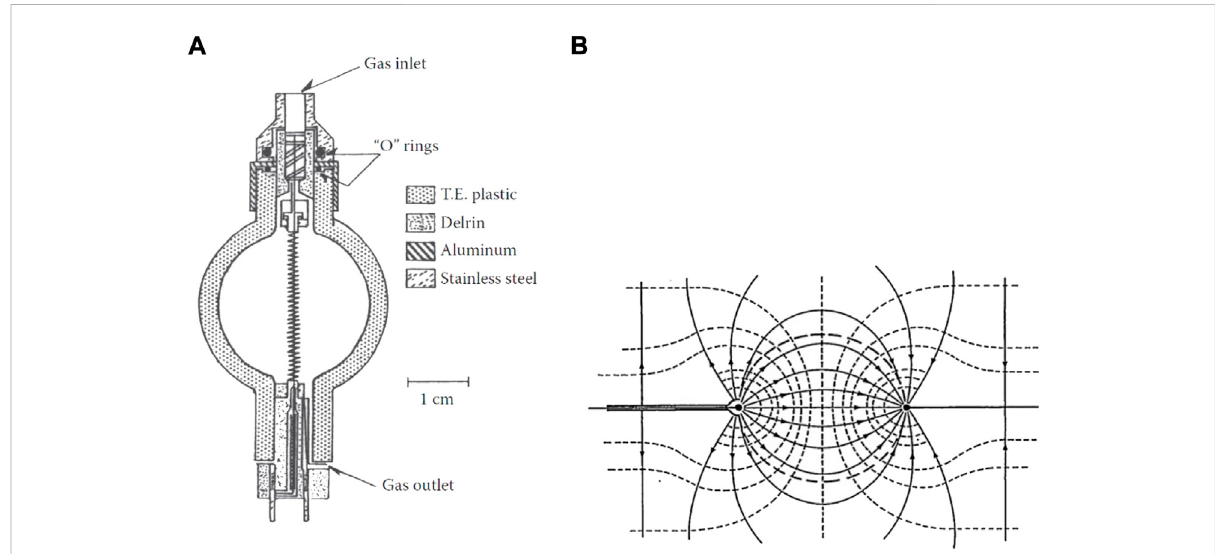
FIGURE 1 Solid-walled and wall-less TEPCs. (A) Cross-sectional view of a solid-walled spherical TEPC, showing the central anode wire, the helical grid, thechamber structure and gas fl ow fi ttings. Source: [6]. (B) Schematic ofawall-less TEPC representing theelectric fi eld lines responsible ofde fi ning the spherical collection volume. Source: